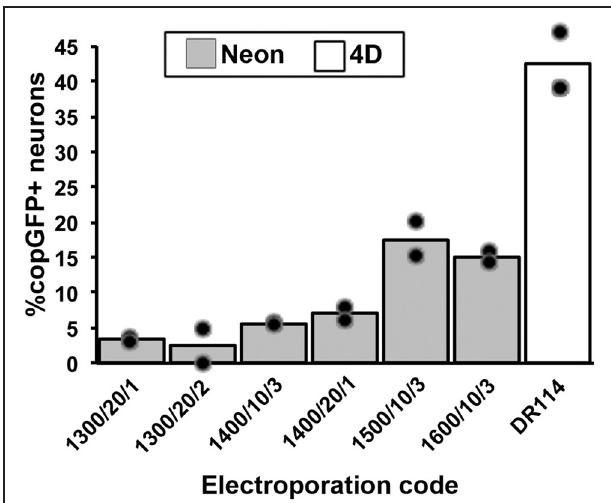
FIGURE 1 | Comparison of transfection efficiency between electroporation devices and programs. Electroporation reactions were conducted in 100 μ l vessels using an equal number of DRG cells and a 10kb plasmid expressing copGFP. Neurons were identified by beta-III-tubulin labeling upon fixation after 48h in culture. The Lonza 4D-Nucleofector system (white bar) resulted in significantly higher transfection rates compared to all programs used with the Invitrogen Neon device [gray bars; parameters listed are electric potential (V)/pulse width (ms)/number of pulses]. Only the six best electroporation codes chosen from previous pilot screens of 29 Neon programs are shown (symbols indicate individual data points for each